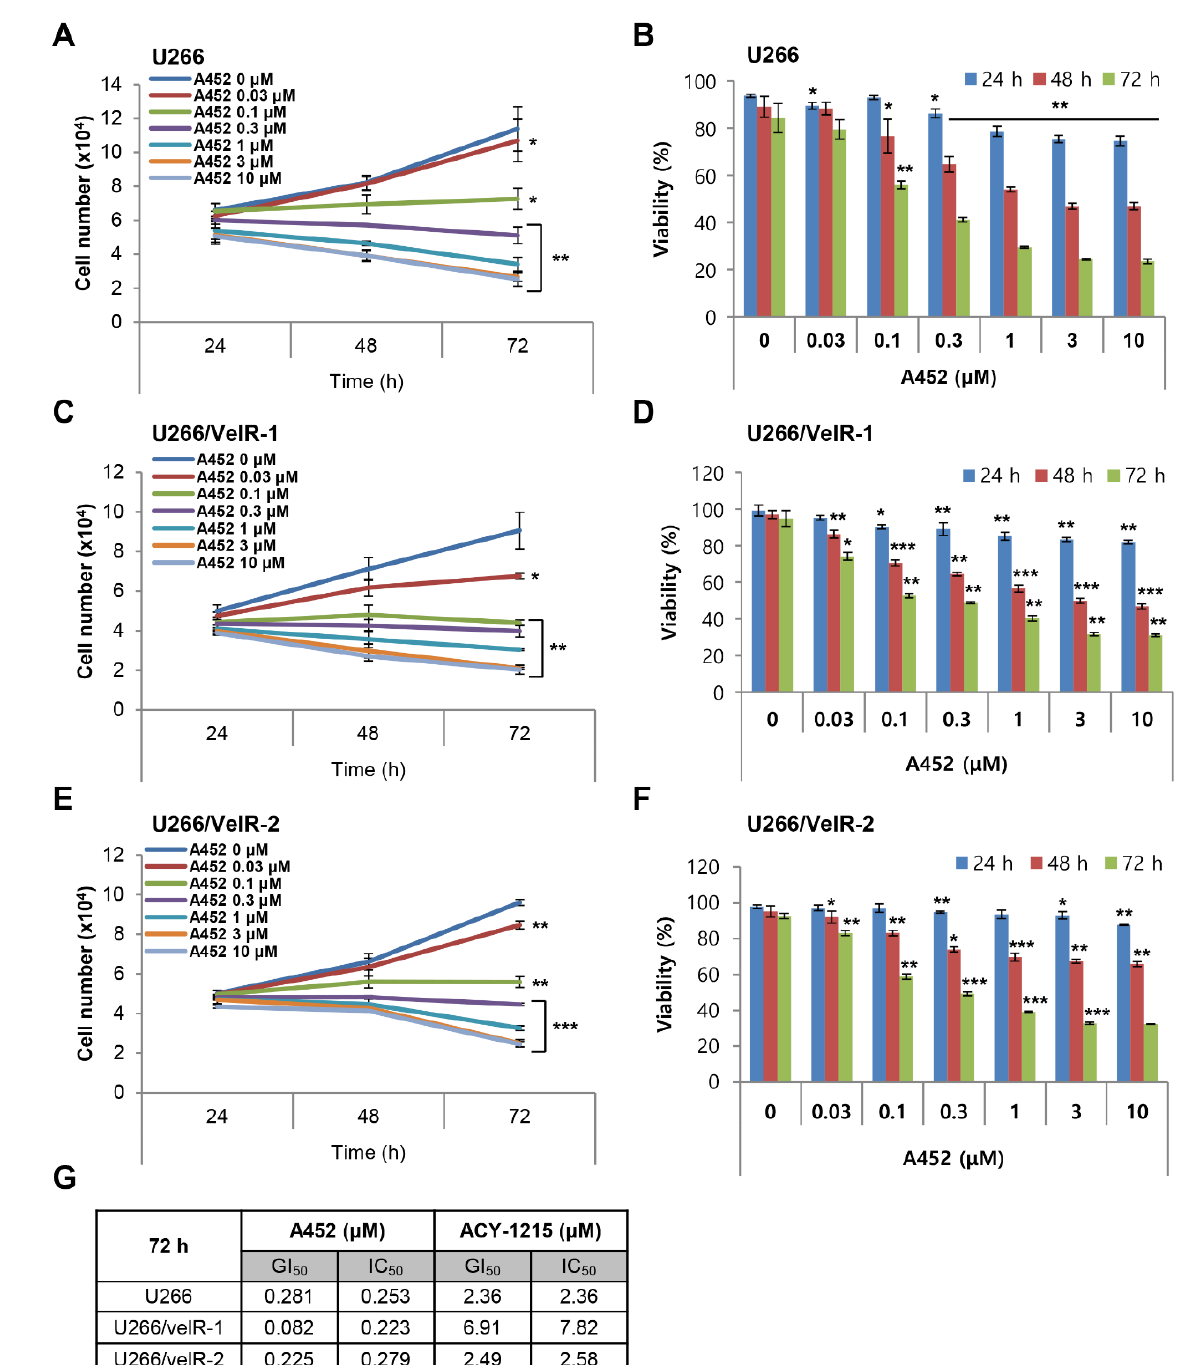
Figure 2. Histone deacetylase 6 (HDAC6)-selective inhibitors suppress cell growth and viability in BTZ-sensitive and BTZ-resistant U266 MM cells. ( A , B ) BTZ-sensitive U266, and ( C – F ) BTZ-resistant U266 (U266/VelR-1 and U266/VelR-2) MM cells were treated with 0.1% DMSO (control) or indicated concentrations of A452 for 72 h, and CCK-8 assays were performed to analyze cell growth and viability. Cell counts were estimated indirectly from a standard curve generated using solutions of known cell counts. Absorbance was normalized to that of the negative control at each time interval. Data present as mean ± SD ( n = 3). * p < 0.05, ** p < 0.01, and *** p < 0.001 vs. the DMSO control, Student’s t -test. ( G ) The IC 50 and GI 50 values for A452 and ACY-1215 in BTZ-sensitive and BTZ-resistant U266 cells using GraphPad prism.